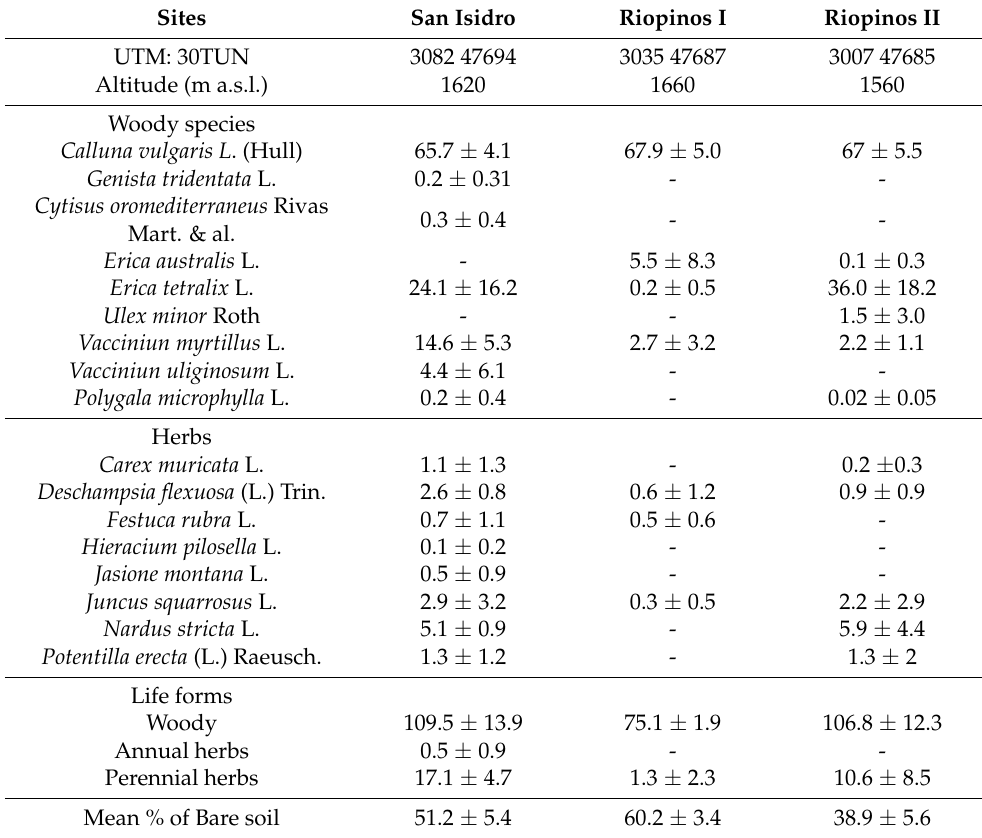
Table 2. Initial vegetation survey results show the mean plant cover (% ± standard deviation) of woody species and more abundant herbs in the three selected heathlands in the Cantabrian Mountain Range (Spain). Sites San Isidro Riopinos I Riopinos II UTM: 30TUN 3082 47694 3035 47687 3007 47685 Altitude (m a.s.l.) 1620 1660 1560 Woody species 65.7 ±